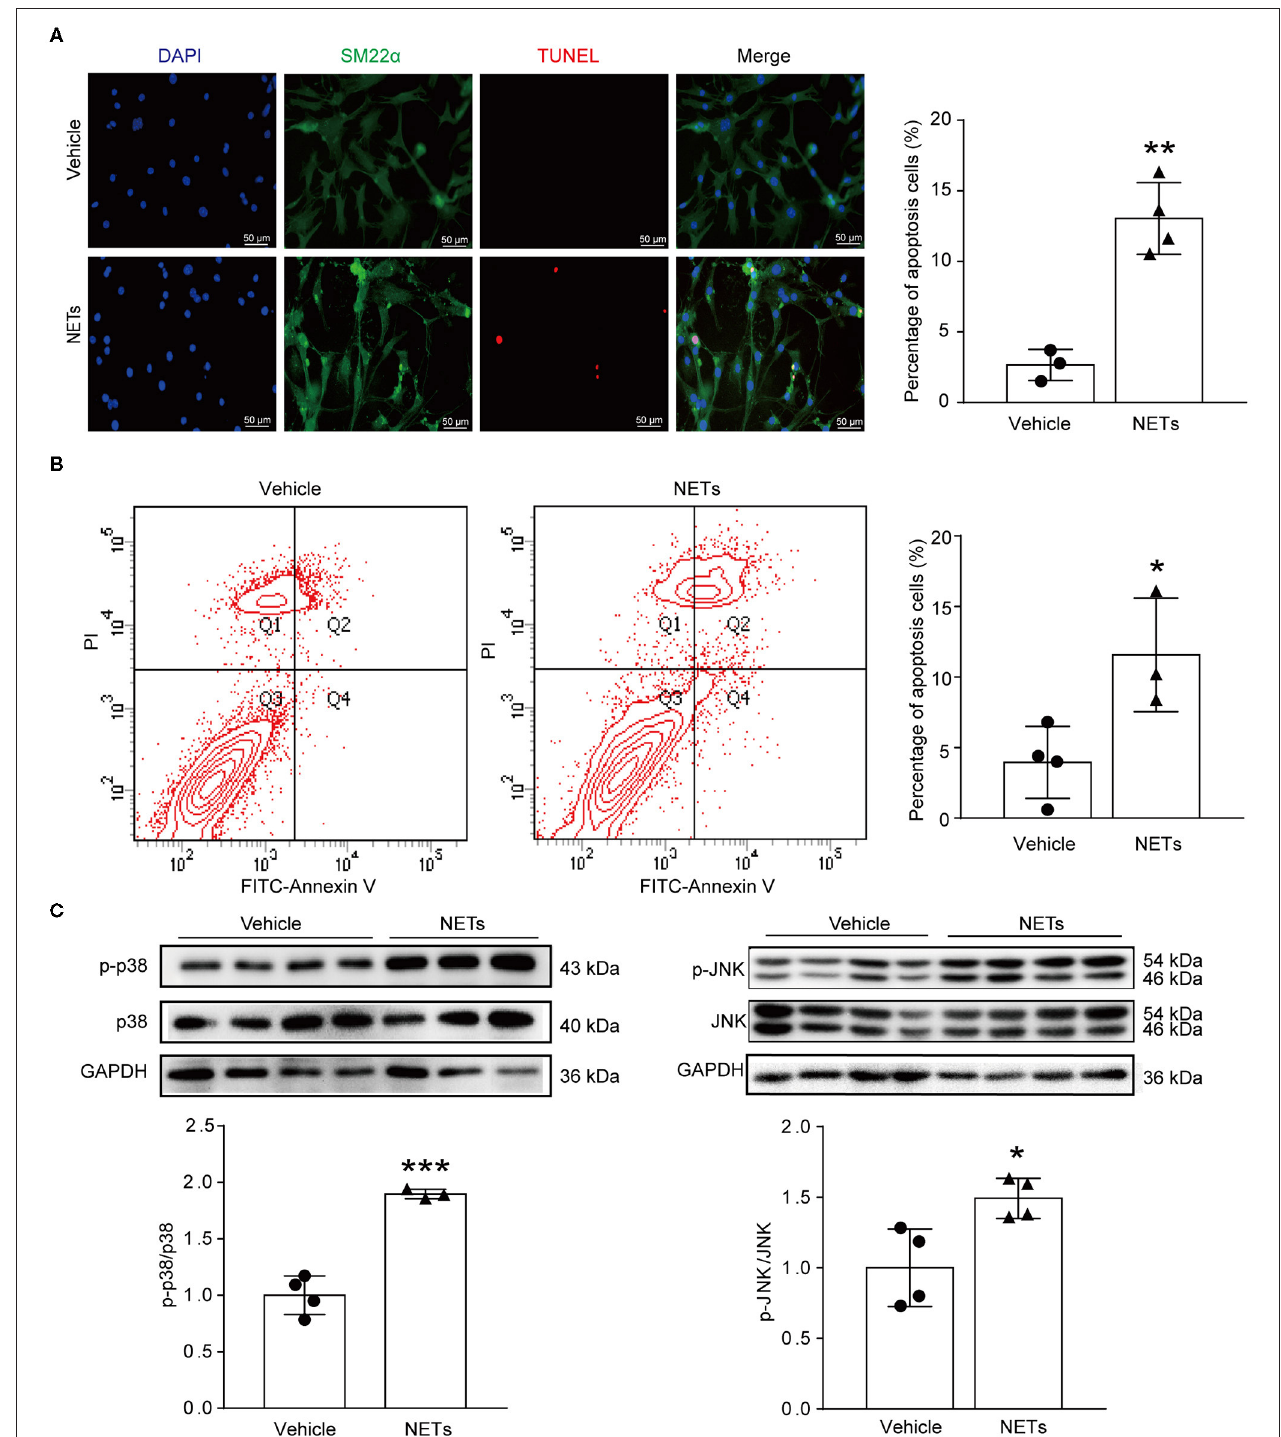
FIGURE 6 | NETs induced VSMC apoptosis via p38/JNK pathway. Primary VSMCs isolated from aortas of ApoE − / − mice were treated with vehicle or 10 µ g NETs for 24h. (A) TUNEL staining for apoptosis cells (red). The percentage of apoptosis cells was analyzed. VSMCs were stained with SM22 α . Nuclei were stained with DAPI. n = 3/vehicle group, n = 4/NET group, ** p < 0.01. Statistical significance was analyzed by the unpaired t -test. (B) Annexin V-FITC/PI staining for VSMC apoptosis. n = 4/vehicle group, n = 3/NET group, * p < 0.05. Statistical significance was analyzed by the unpaired t -test. (C) Western blot for p38/JNK level. n = 3–4, * p < 0.05, *** p < 0.001. Statistical significance was analyzed by the unpaired t -test.